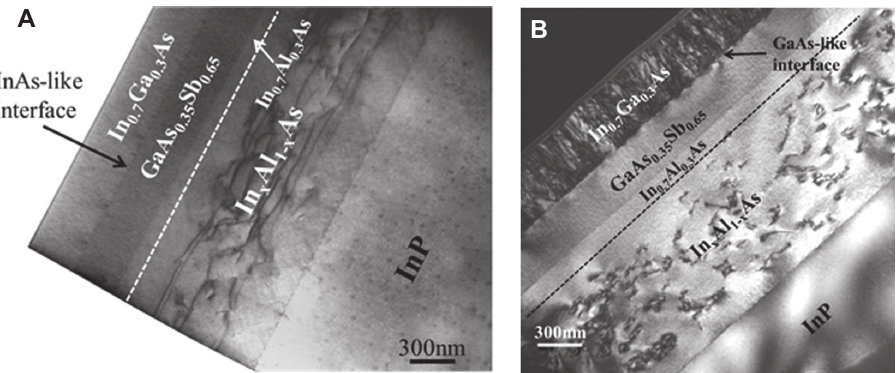
Sb /In Ga As staggered gap 0.35 0.65 0.7 0.3 Sb and In Ga As layers of the InAs-like interface structure, indicating 0.35 0.65 0.7 0.3 Sb / 0.35 0.65